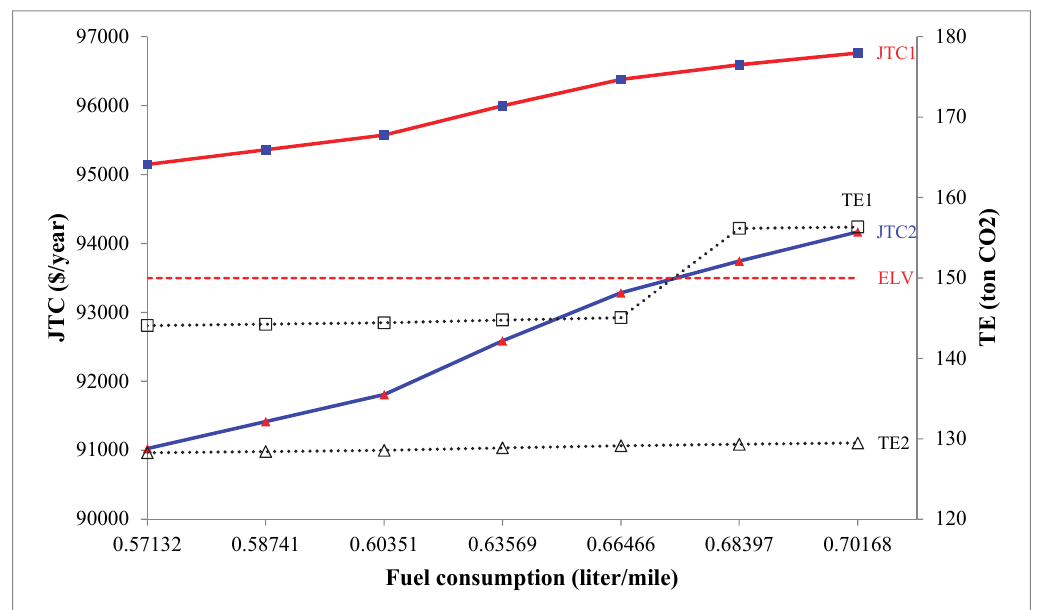
Fig. 12. Effect of changing in fuel consumption on total cost and total